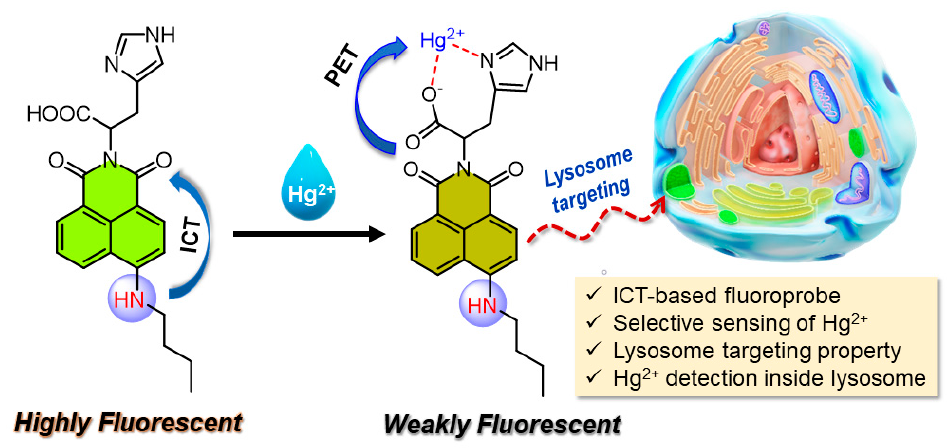
Scheme 1. Schematic illustration of detection of mercury and lysosomal imaging using His-NMI-Bu fluoroprobe.